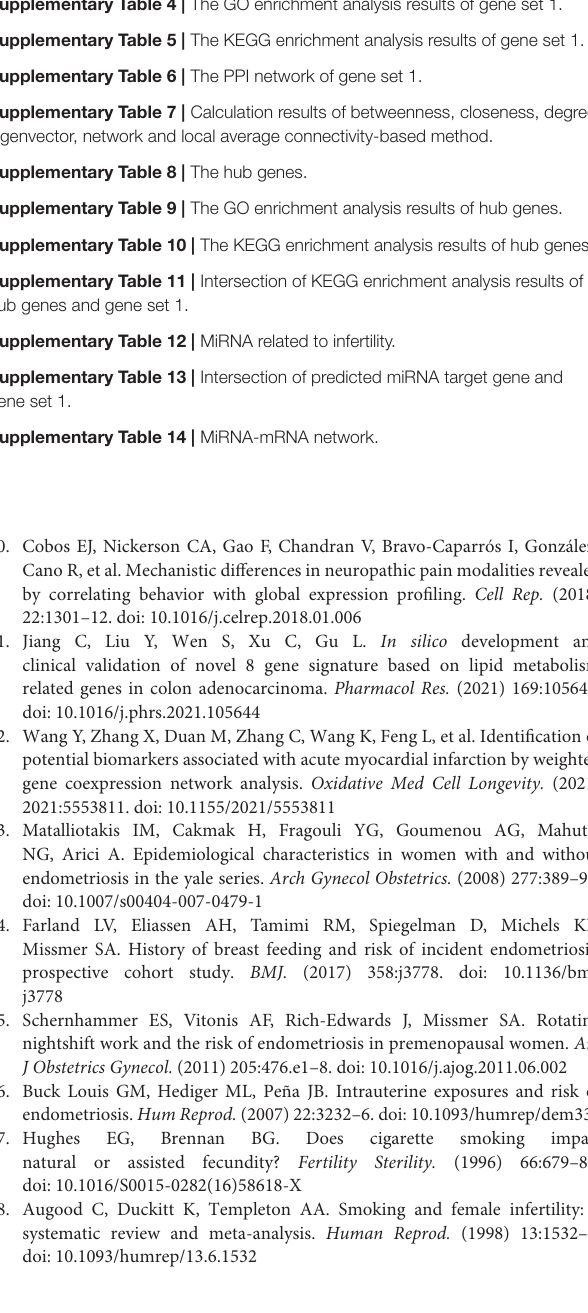
Supplementary Table 3 | The genes in gene set 1. Supplementary Table 4 | The GO enrichment analysis results of gene set 1. Supplementary Table 5 | The KEGG enrichment analysis results of gene set 1. Supplementary Table 6 | The PPI network of gene set 1.